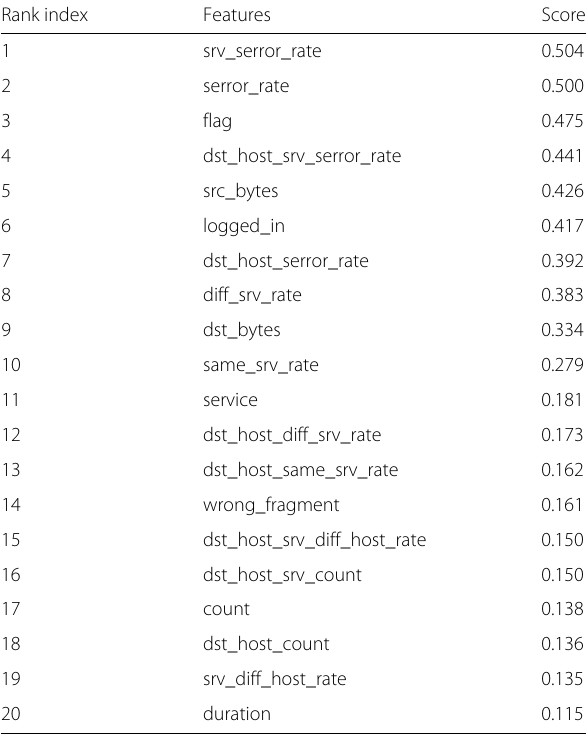
Table 5 Top features for detecting DoS, used in the second